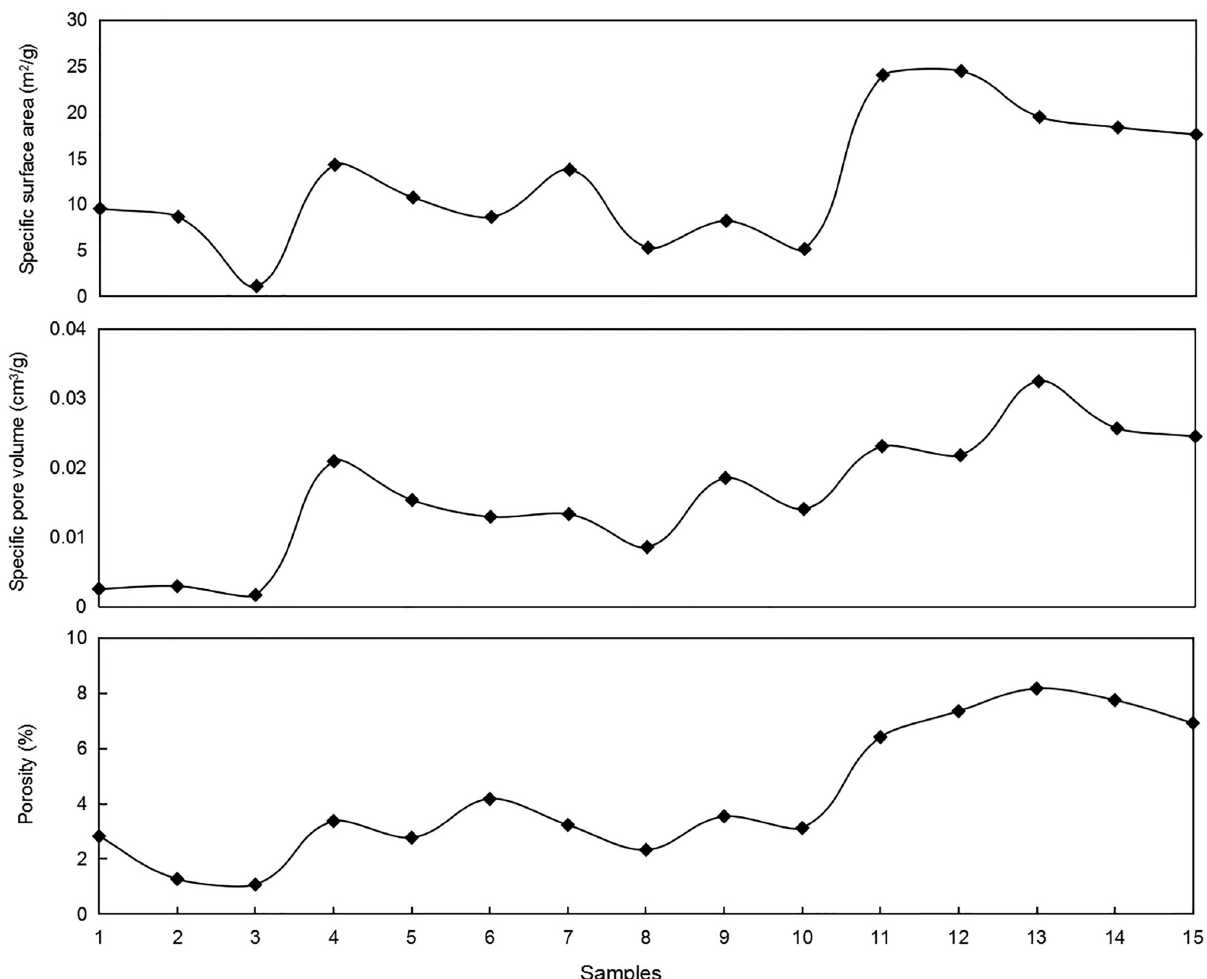
Fig 7. Distributions of porosity, specific surface area, and specific pore volume of different